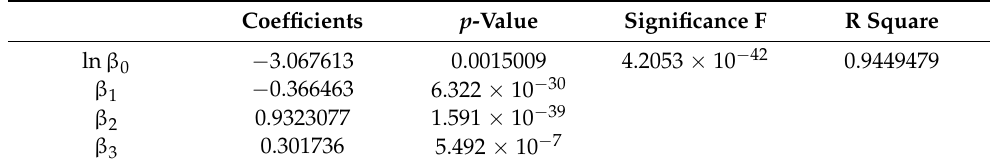
Table 5. Regression analysis results.